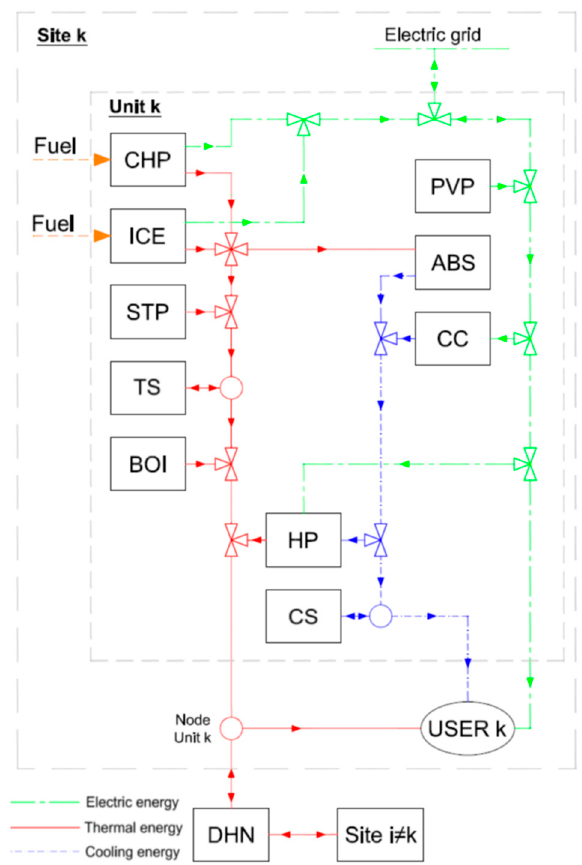
Figure 7. Superstructure of the distributed generation solution. Table 9. Optimal configurations of the distributed generation solution.